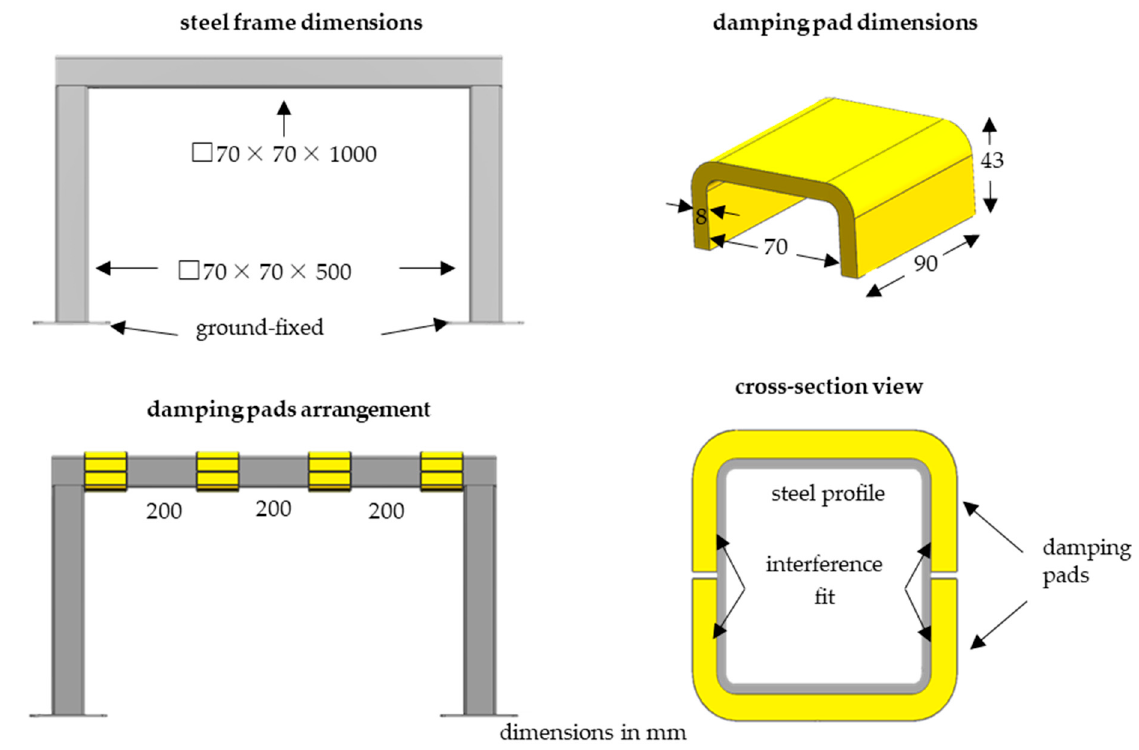
Figure 1. Visualization of analyzed objects. Table 2. Mass of subsequent damping pads and steel frame.